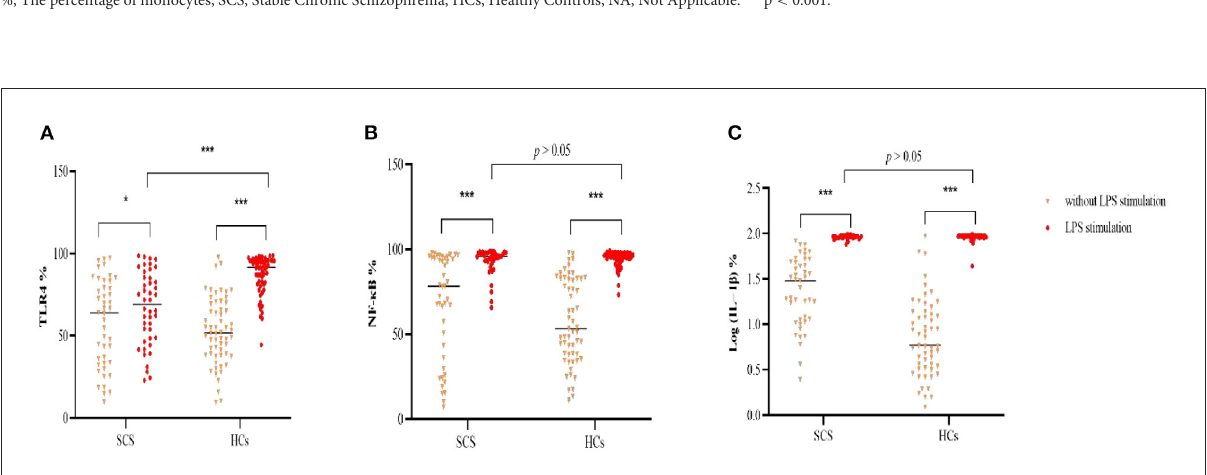
FIGURE2 Comparison of percentage of monocytic TLR4 (A) , NF- κ B (B) and log (IL-1 β ) (C) following LPS stimulation between schizophrenia patients and healthy controls. TLR4, Toll-like receptor 4; NF- κ B, nuclear factor-kappa B; IL-1 β , interleukin-1 β ; LPS, lipopolysaccharide; %. The percentage of monocytes. * p < 0.05; *** p < 0.001.